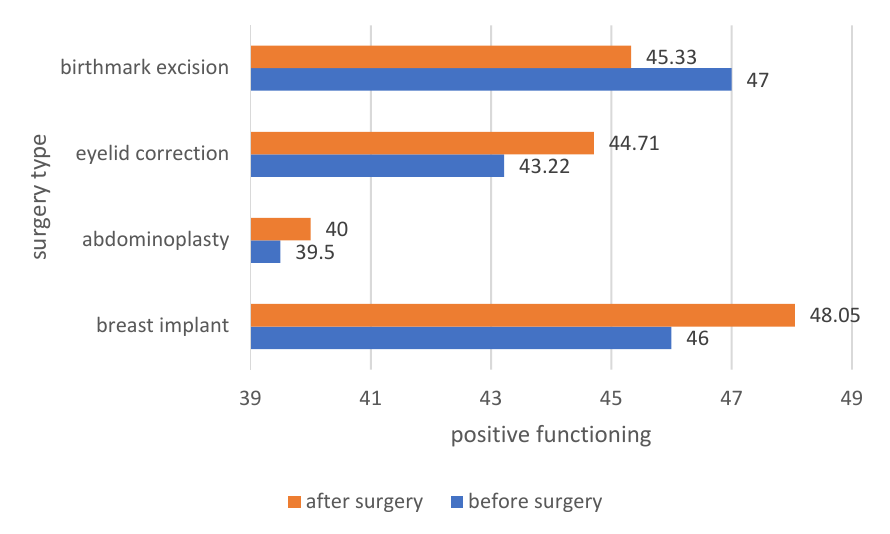
Figure 7. Comparison of the sense of well-being among patients before and after the procedure.